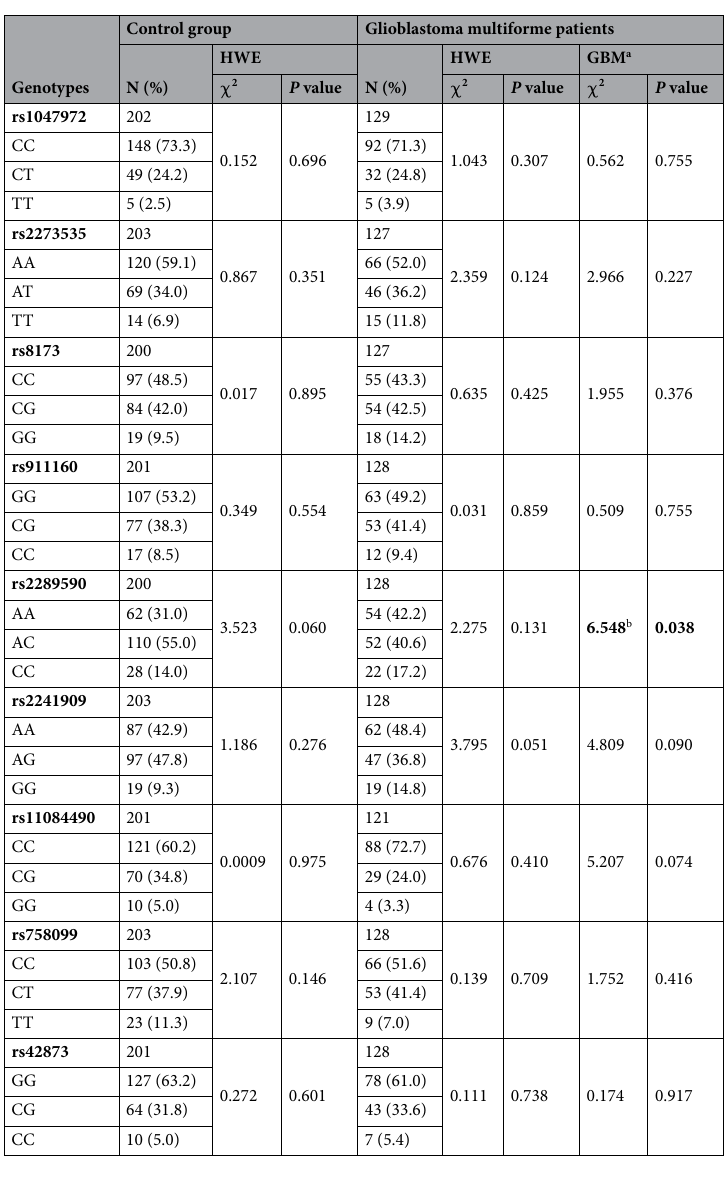
Table 3. Genotypes frequencies and Hardy–Weinberg equilibrium for the studied polymorphisms. GBM glioblastoma multiforme, HWE Hardy–Weinberg equilibrium, χ 2 Chi-square statistics. a χ 2 analysis between GBM patients and controls. b Fisher statistics. Statistically significant values are highlighted in bold characters ( P ≤